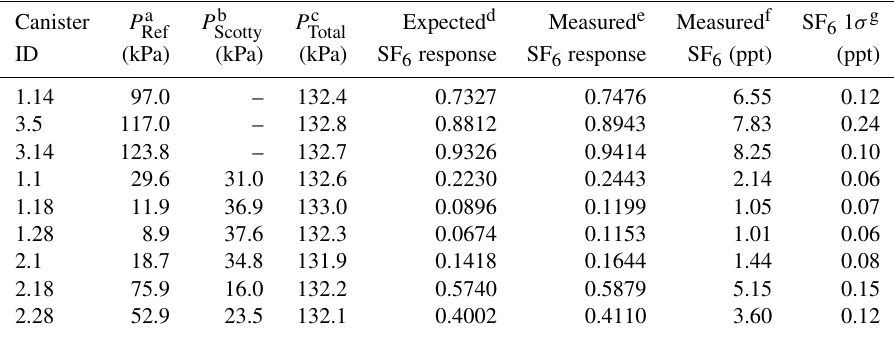
Table 2. Characteristics of nine manometric SF 6 dilution samples prepared at Portland State University. P b P c Canister P a Expected d Measured e Measured Ref Scotty Total